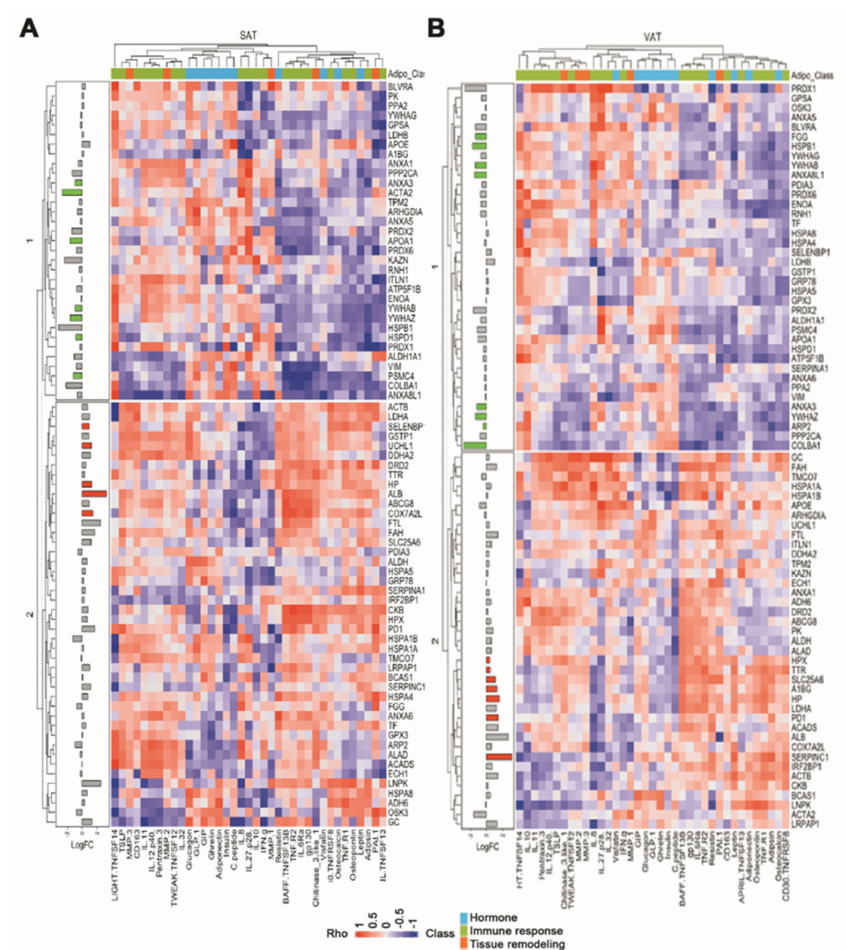
Figure 5. Influence of white adipose tissue proteome composition on adipokine profile. Heatmap depicting Spearman’s Rho correlation coefficient between SAT ( A ) or VAT ( B ) detected proteins (rows) and measured adipokines (columns). Log fold-change of AT between T2DM and nonT2DM individuals is represented alongside the heatmap. Colored bars indicate significance ( p < 0.05). Rho, Spearman’s Rho correlation coefficient; LogFC, log